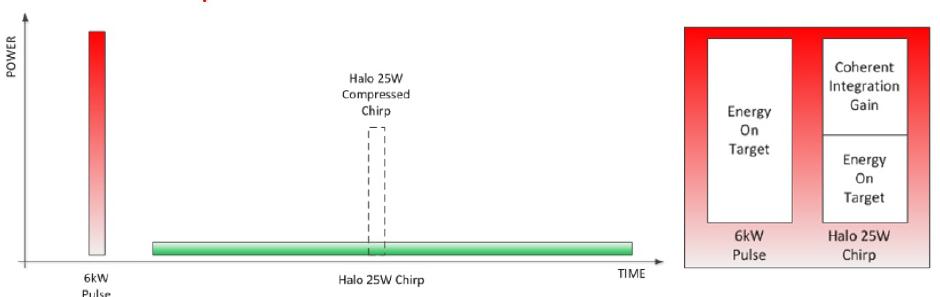
Figure 1. Developer’s explanation of why pulse power can be reduced in pulse compression radars [19].